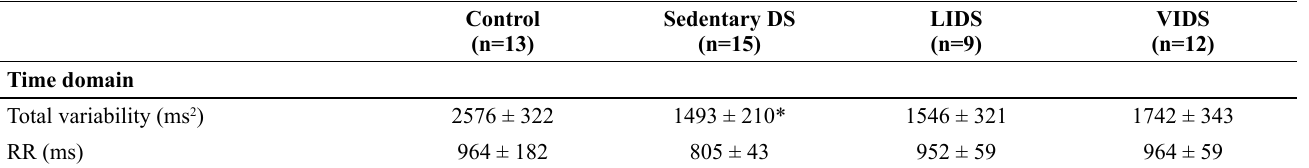
Table 2. Comparison of values obtained in the Heart Rate Variability evaluated in the time and frequency domains and Symbolic Analysis in investigated